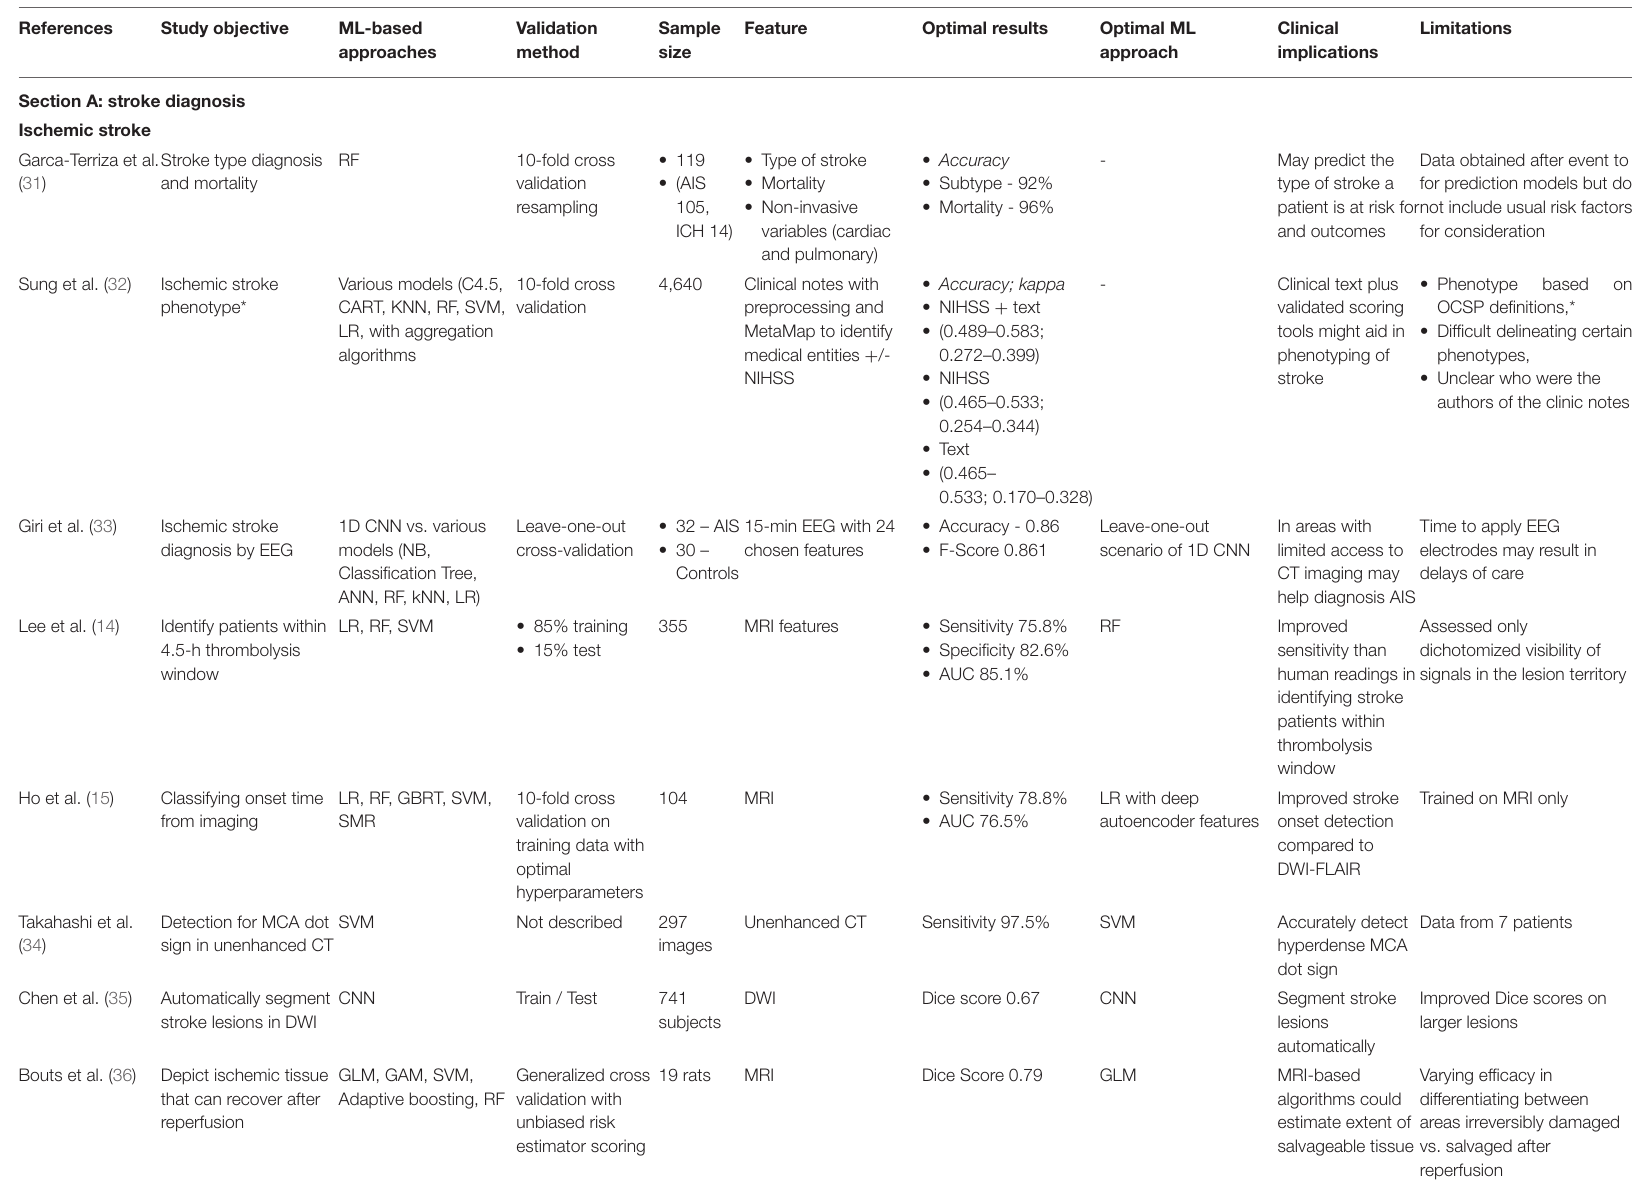
TABLE 1 | Studies utilizing machine learning for stroke diagnosis and